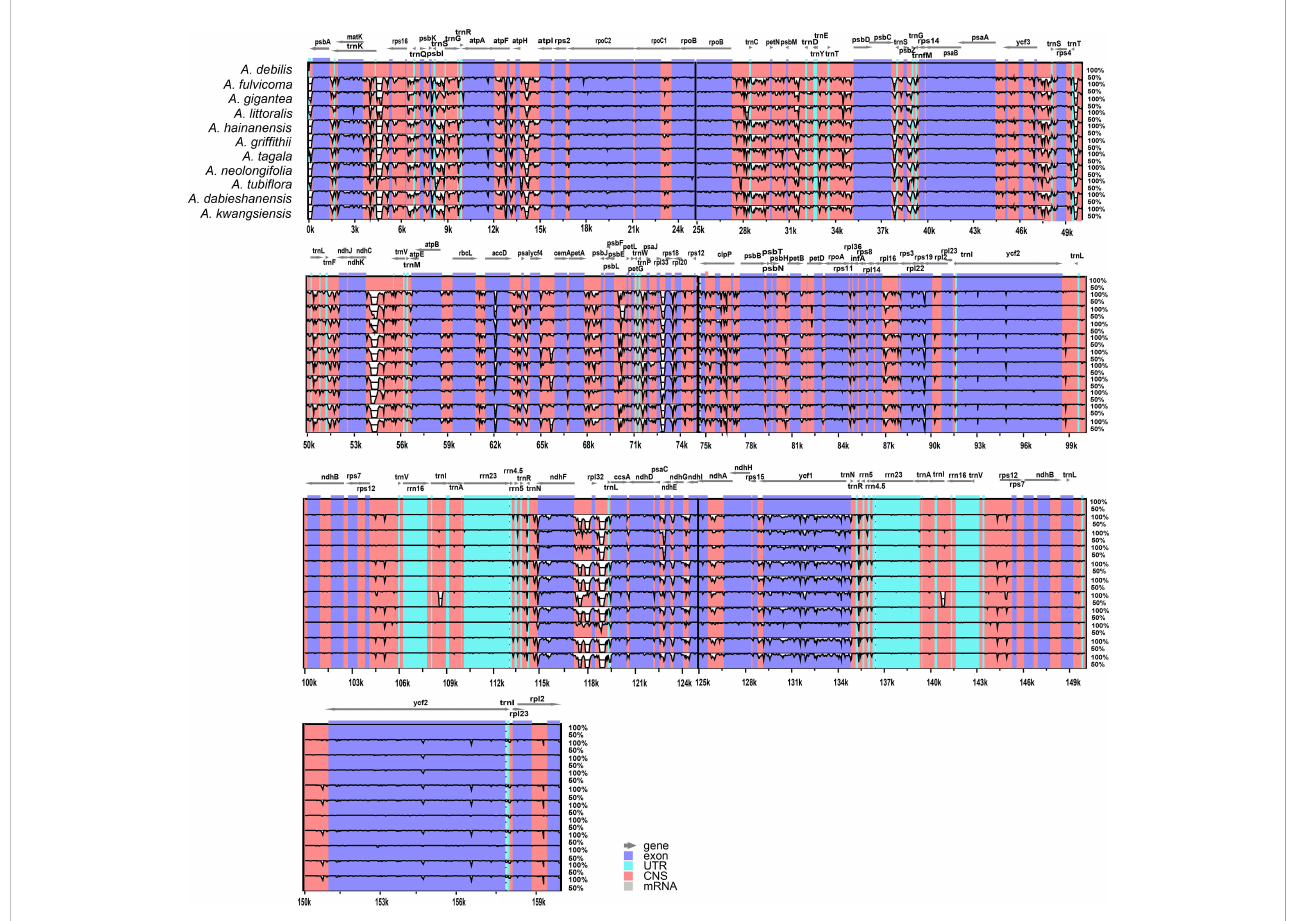
FIGURE 4 Sequence identity plot comparing the four chloroplast genomes of species of Aristolochia with Aristolochia debilis as a reference using mVISTA. Gray arrows and thick black lines above the alignment indicate genes with their orientation. Purple bars represent exons, blue bars represent UTRs, and red bars represent noncoding sequences (CNS). Y-scale represents the percent identity ranging from 50% to